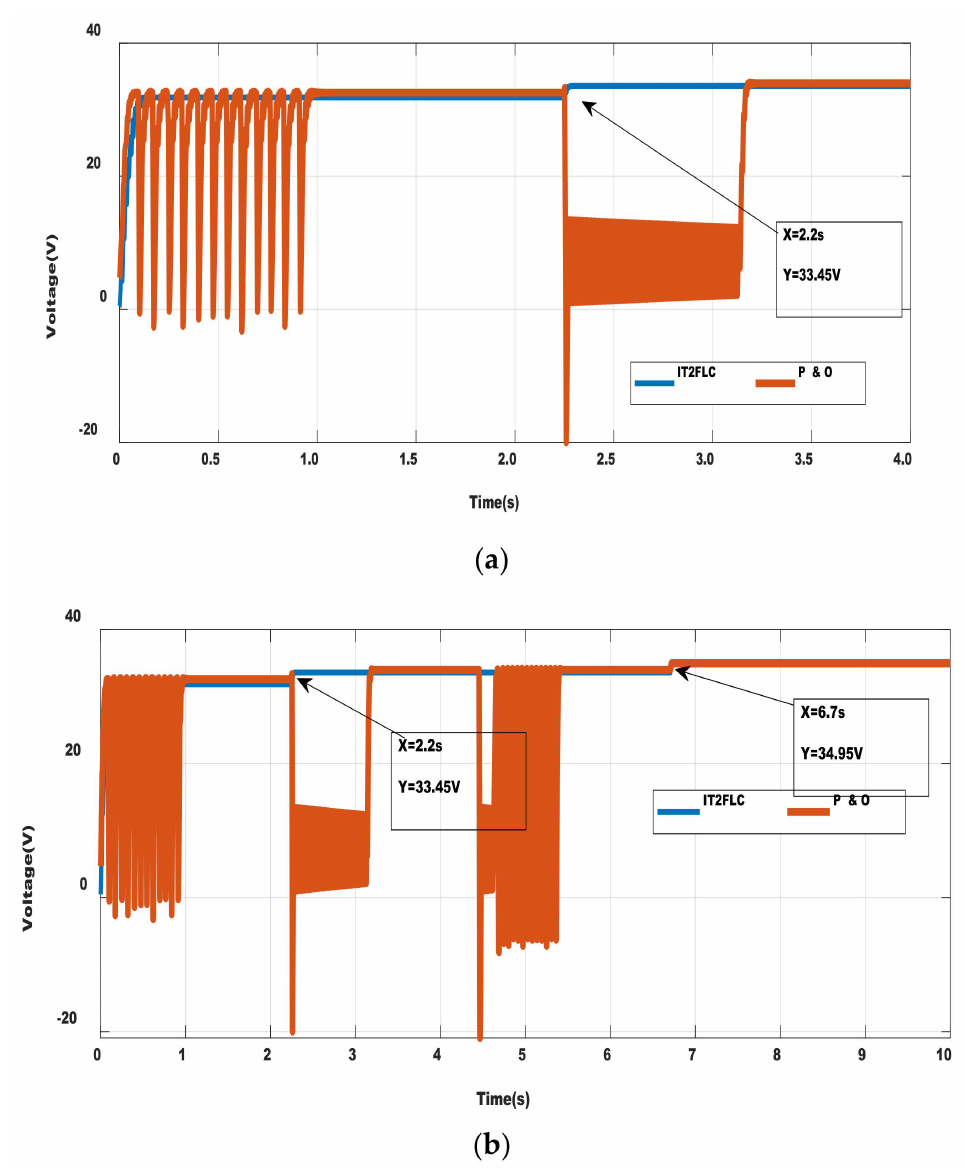
Figure 19. ( a ) Voltage response for variable time; ( b ) Voltage response for variable time. Case 3: Variable irradiance and temperature conditions (200–1000 W/m 2 , 25–40 ◦